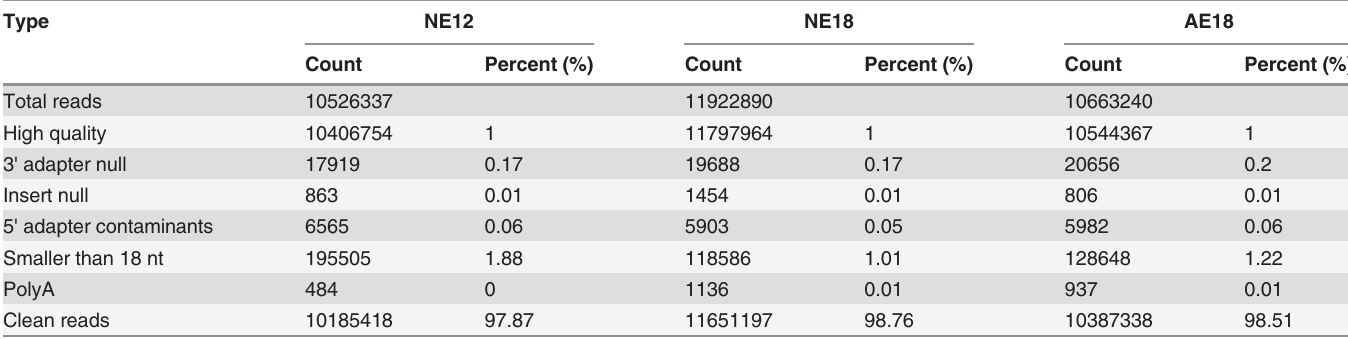
Table 1. Summary of filtered data produced by small RNA